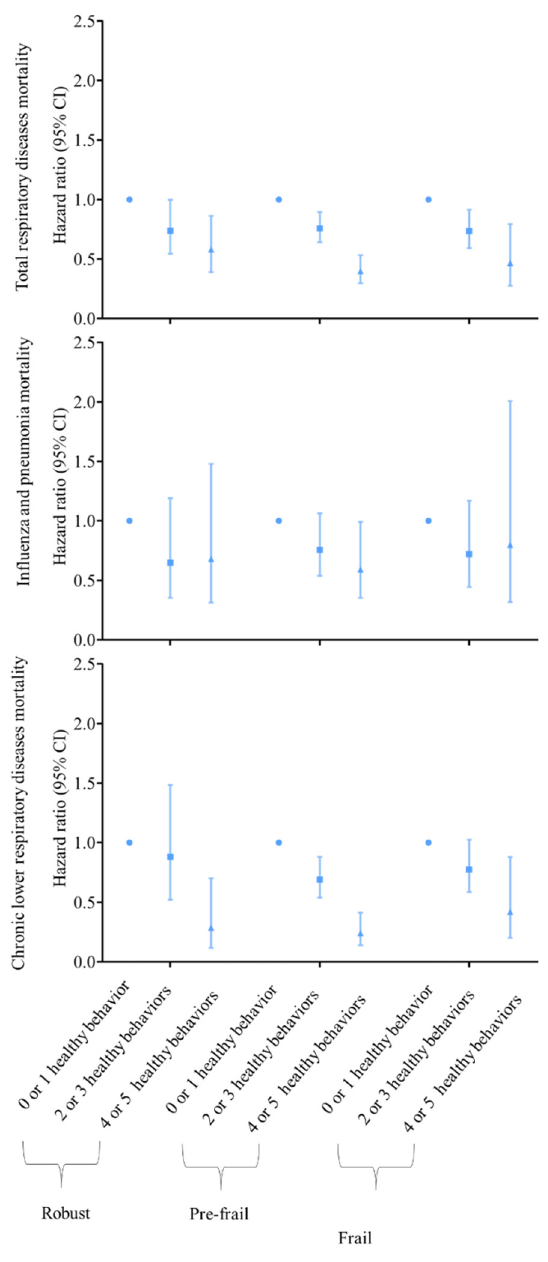
Figure 1. Associations of healthy behaviour with respiratory diseases mortality by frailty. Models all adjusted for age, sex, TDI, educational level, race and ethnicity, general health, cancer, diabetes, cardiovascular disease, poor psychological status, family history, sleep duration, coffee intake and consumption of tea. HR= hazard ratio. 95% CI = 95% confidence interval.